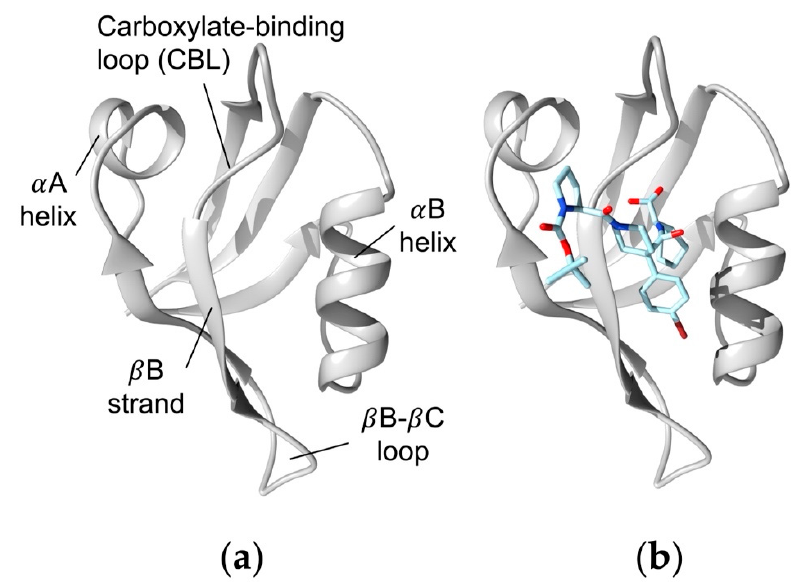
Figure 1. The PICK1 PDZ domain. ( a ) PICK1 PDZ domain with labeled secondary structures (PDB ID: 6BJO). ( b ) PICK1 PDZ-BIO124 complex with BIO124 shown in blue (PDB ID: 6BJO). Note that ( b) is the starting structure of the all-atom MD simulations.